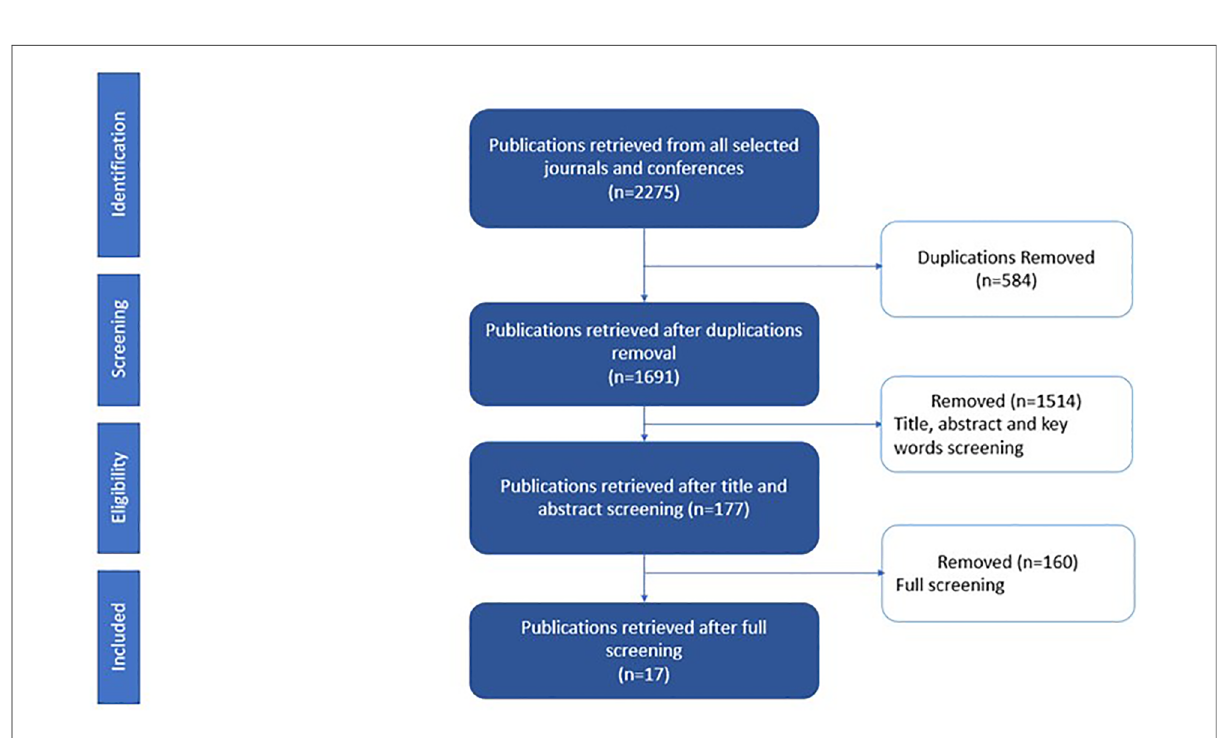
FIGURE 2 PRISMA selection process fl ow